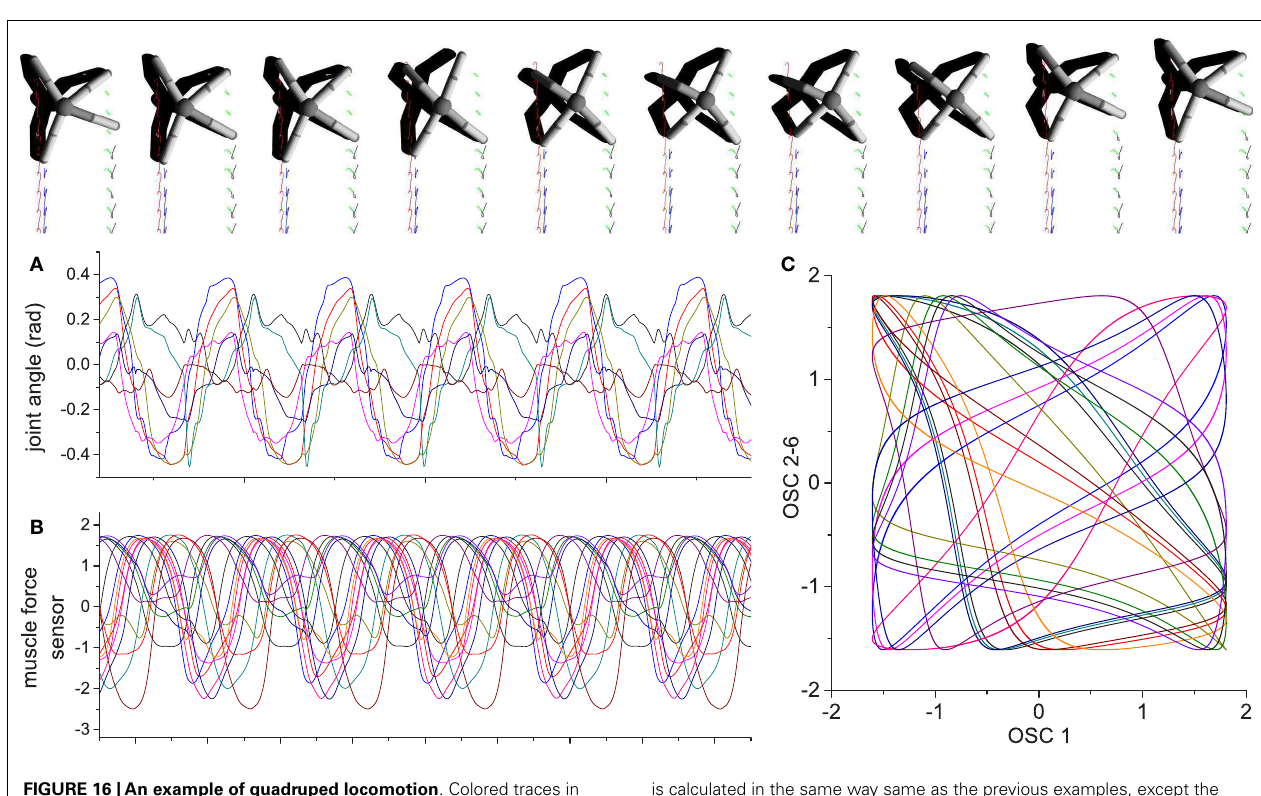
FIGURE 16 |An example of quadruped locomotion . Colored traces in the snapshot images represent the foot contact trajectories of each leg. (A,B) are time plots of the 8 joint angles and 16 muscle force sensors, (C) depicts the output of oscillators 2–16 vs. oscillator 1.The parameters of the physical model are given in the Supplementary Material. Muscle force